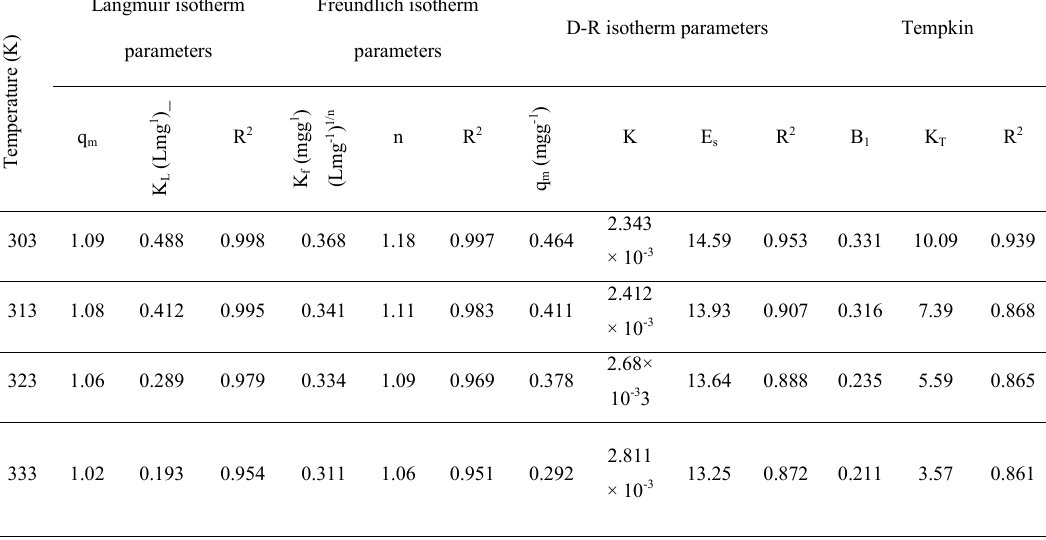
Table 2. Adsorption isotherm constants for adsorption of fluoride onto eggshell powder at different temperatures.